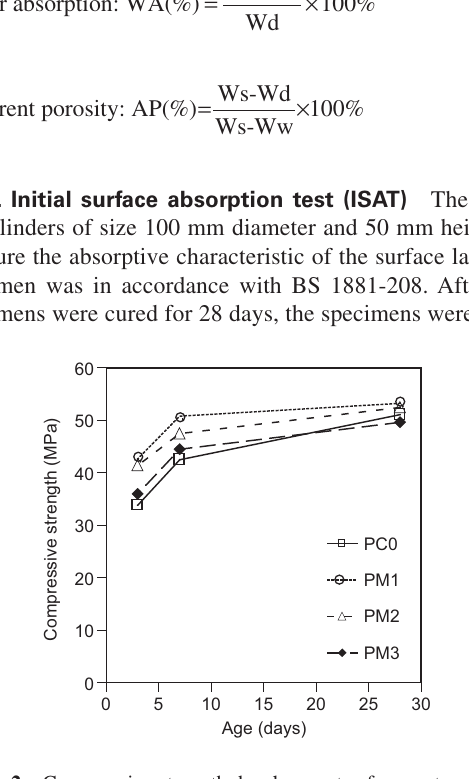
Figure 2 Compressive strength developments of cement pastes vs.